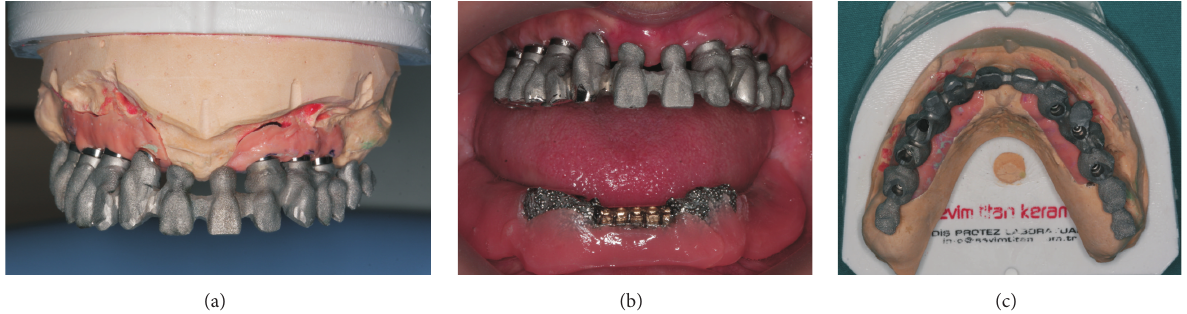
Figure 8: (a) Occlusal view of metal substructure, (b) frontal view of metal substructure, and (c) metal try-in.